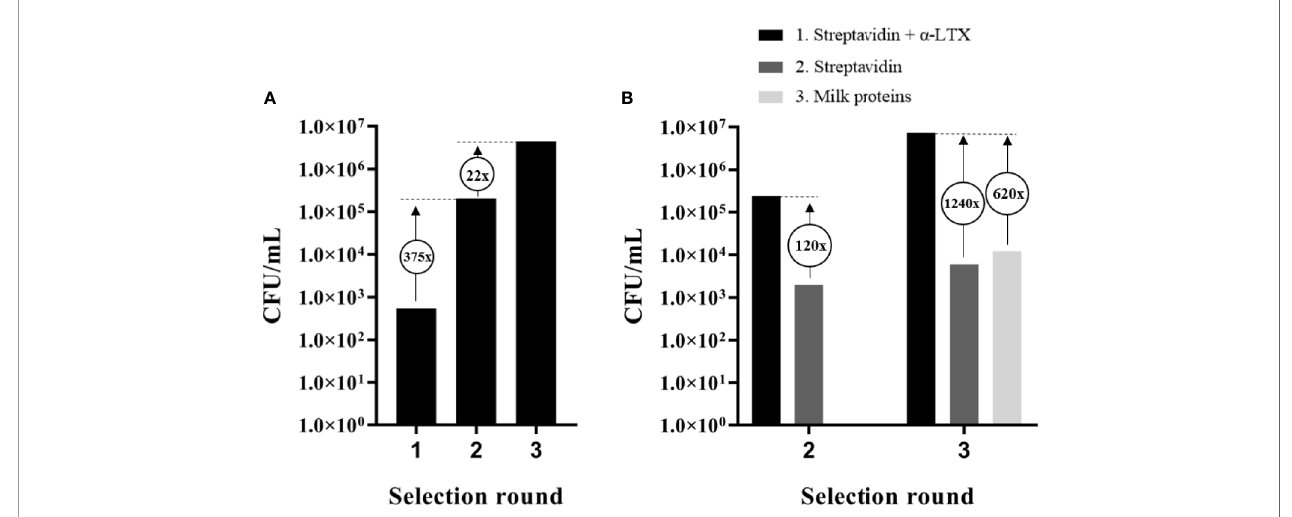
FIGURE 1 | Output and assessment of phage display selections against a -LTX. (A) Accumulation of scFv-displaying phages from the IONTAS phage display library l with af fi nity to a -LTX over three rounds of selection. An increase in CFU/ml of 375-fold and 22-fold respectively were observed between the selection rounds. (B) CFU/ml was determined for output phages from selection round two and three for binding to either a -LTX, streptavidin, or milk proteins. An increase of 30-fold between the second and third selection round was observed in CFU/ml for the phages that bound streptavidin-captured a -LTX. Only few phages with af fi nity to streptavidin or milk proteins were accumulated compared to phages with af fi nity to a -LTX.